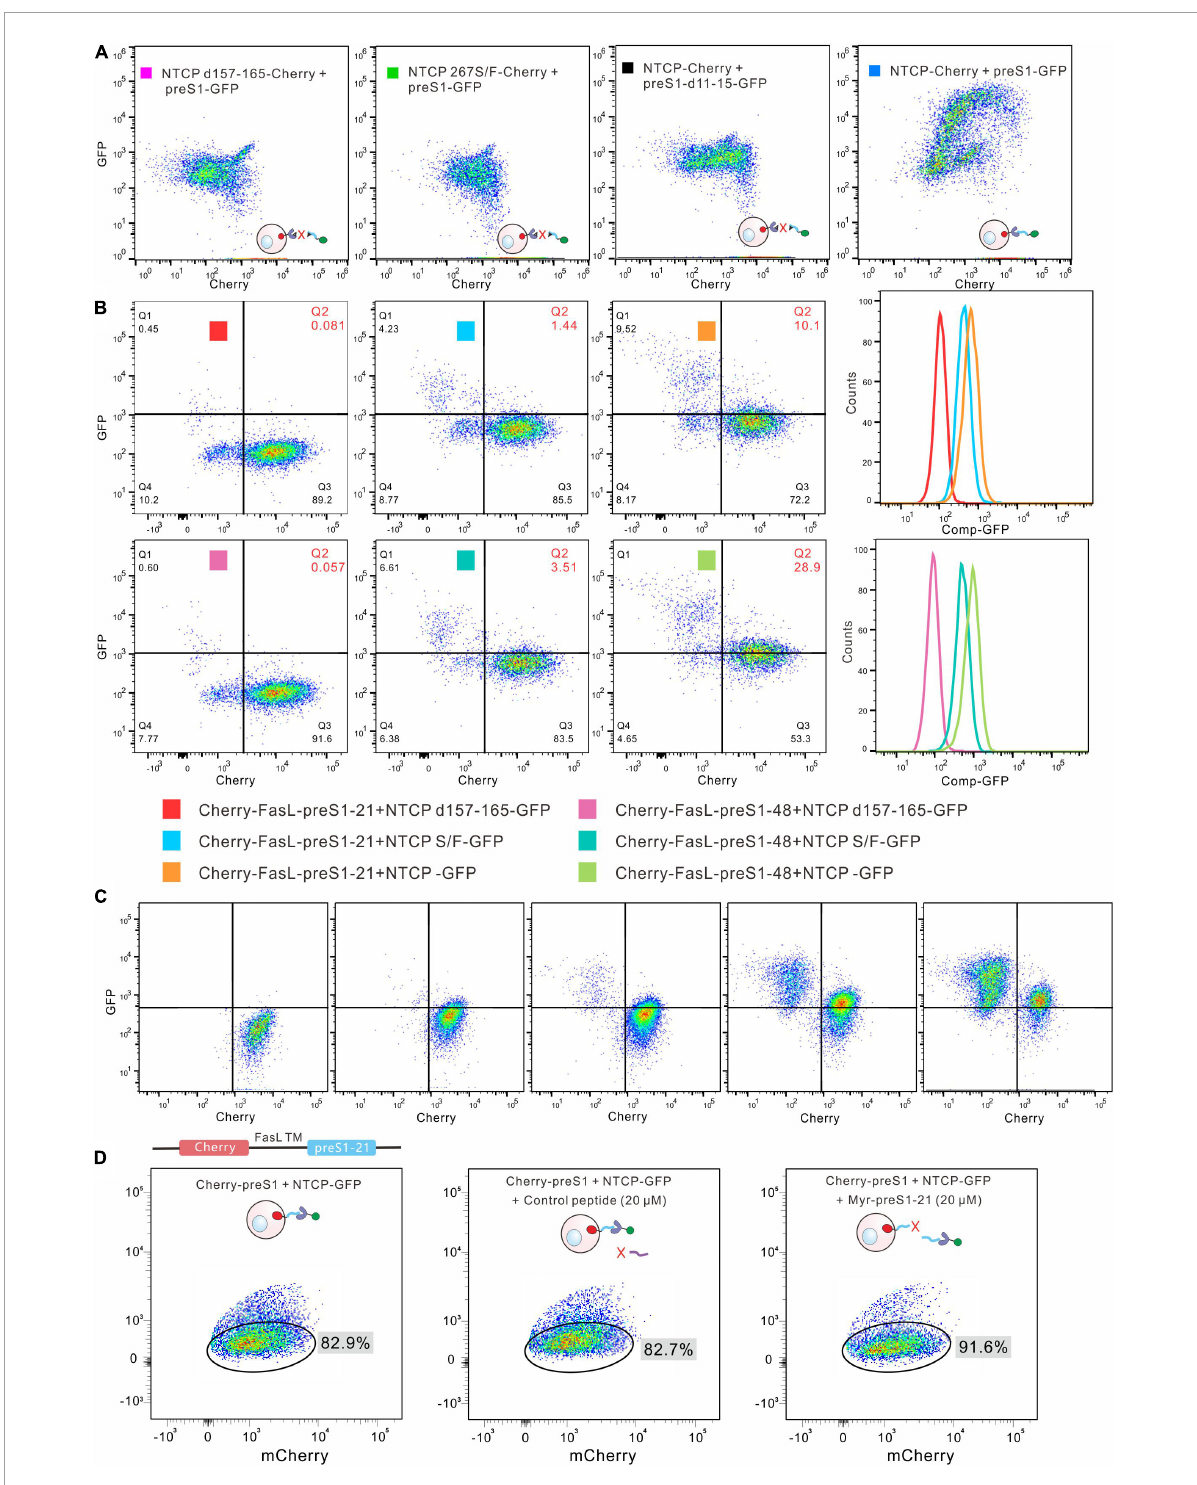
FIGURE2 Detection of the interaction between preS1 and NTCP by cell-surface display. (A) Detection of preS1-NTCP interaction by the cell-surface display. Wild type NTCP-mCherry was displayed on the cells, and preS1-GFP was used as the bait protein. The interaction was abolished in both the preS1 mutants and the NTCP mutants. (B) The preS1 peptides were displayed on the cell surface, and NTCP-GFP on the membrane was used as the bait protein. The mutated NTCP (NTCP d157-165 or 267S/F) lost its affinity for the preS1 peptide, leading to no or low green fluorescence on the Cherry-FasL-preS1-48 cells. The affinity of preS1-48 for NTCP is higher than that of preS1-21, resulting in more green fluorescence on the Cherry-FasL-preS1. (C) . Increasing the amount of NTCP-GFP (from left to right) led to increased green fluorescence detected on the Cherry-preS1-21 cells. (D) . Competitive assays. Myr-preS1-21s or control peptide was used to compete with preS1-21 on the cell